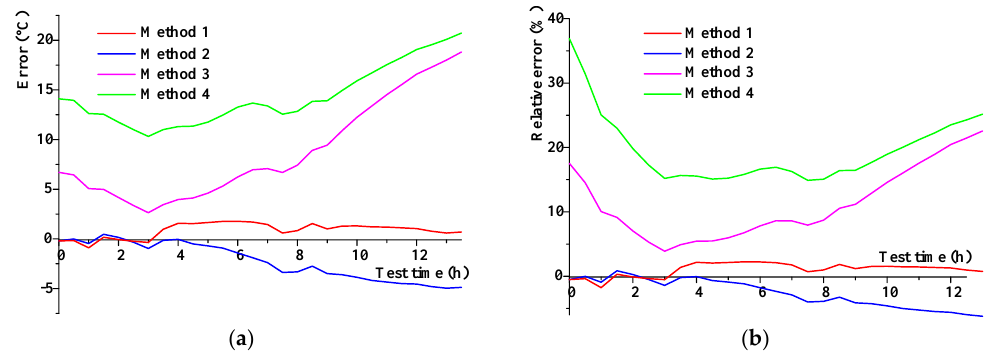
Figure 9. Calculation error analysis of conductor-temperatures in Case 1: ( a ) error variation and ( b ) relative error variation.